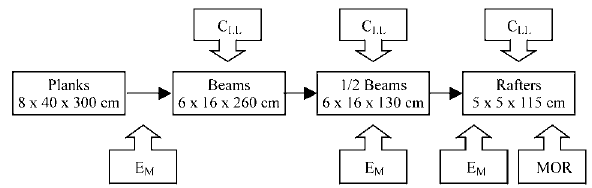
Figure 1. Diagram of the sequence of the experimental stages. Figure 3. Positioning of the transducers.